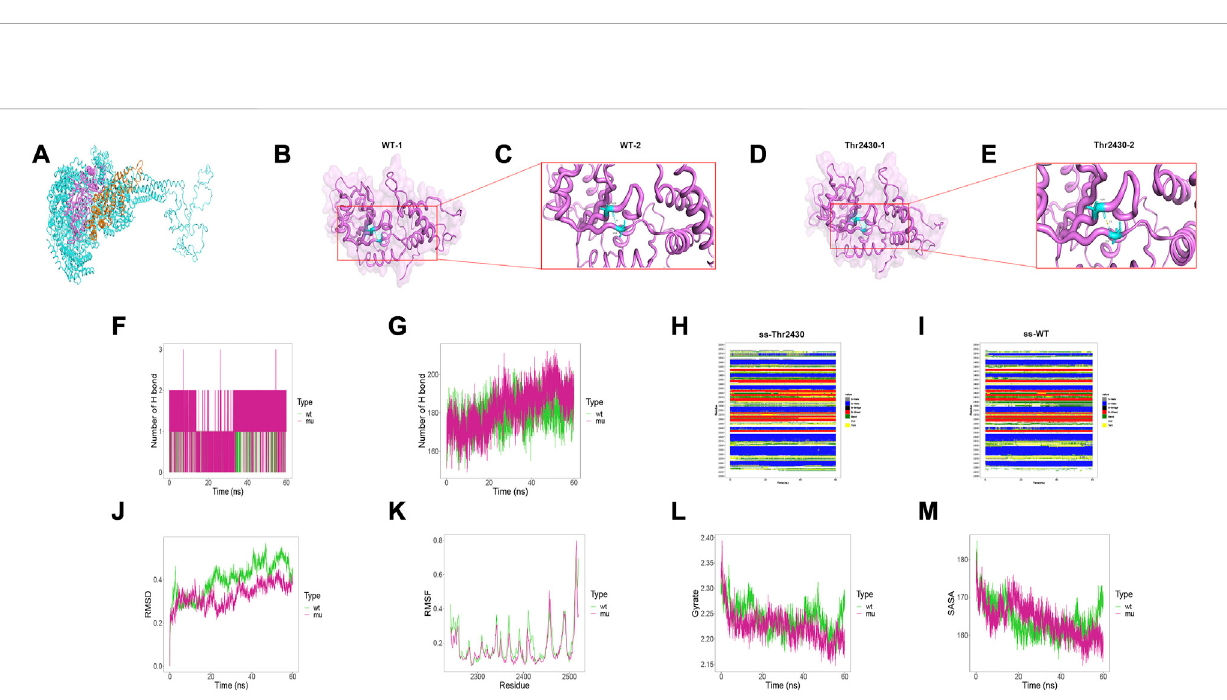
FIGURE 4 Results of structural analysis and molecular dynamics simulation of DYNC2H1: c.7289T > C (p.Ile2430Thr) variation. (A) Protein structure of DYNC2H1. (B, C) The wild-type structure of DYNC2H1: protein (DYNC2H1), and enlarged image of the segment containing Ile2430 residue. (D, E) The mutant structure of DYNC2H1, and segment containing the variant Thr2430 residue. (F) The number of hydrogen bonds formed between the target amino acid (meaning Ile2430 or Thr2430) and other residues. (G) Total number of hydrogen bonds in the wild-type model and the mutant model, respectively. (H, I) Comparison of local secondary structure data between Ile2430Thr mutant and wild-type. (J) RMSD: a numerical measurement indicating the difference between two structures. (K) RMSF: is a numerical measure similar to RMSD, but instead ofindicating differences in position over time between entire structures; it calculates the fl exibility of individual residues, or the extent to which a particular residue moves ( fl uctuates) during a simulation. (L) Gyrate:isameasureofthestructuraldisplacementofaproteinatomwithitscommoncenterofmassoverthecourseofthesimulationand provides comprehensive information about protein tightness over time. (M) SASA: measures the exposed surface in a protein structure accessible to solvent